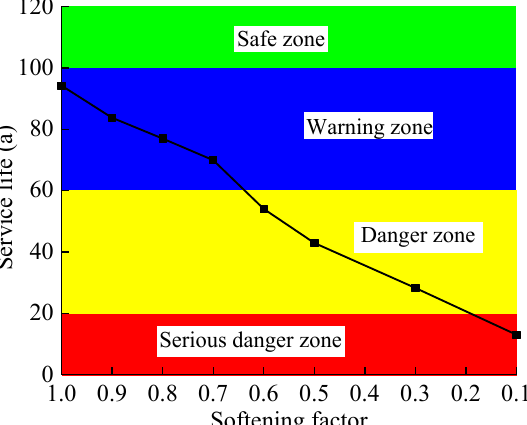
Figure 17. Service life of base structure with different softening coefficients.